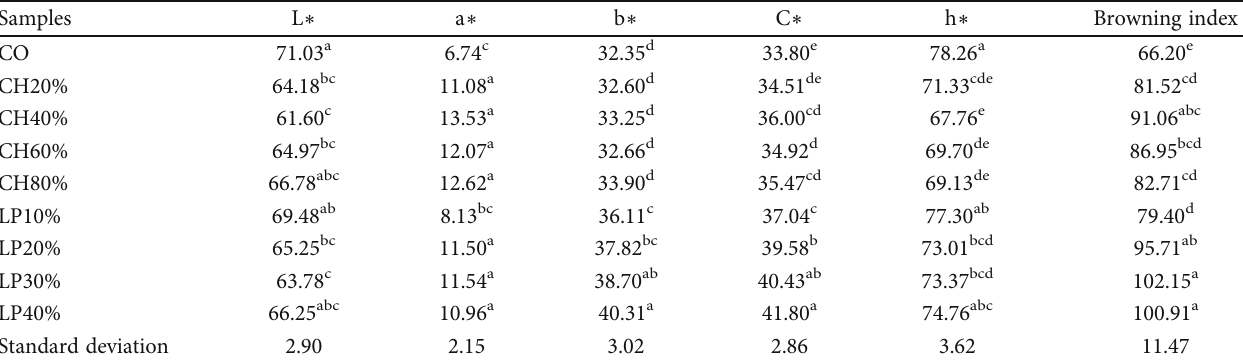
Table 1: E ff ects on color coordinates and Browning index of crackers by the addition of chickpea and lupine fl our. Samples